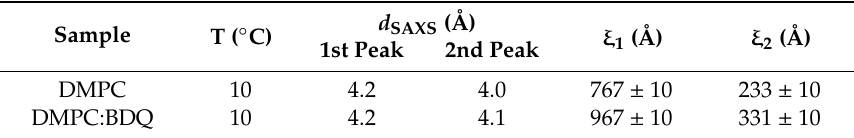
Table 2. Wide-angle X-ray scattering (WAXS) di ff raction patterns of DMPC and DMPC with BDQ at 5% molar ratio at 10 ◦ C.